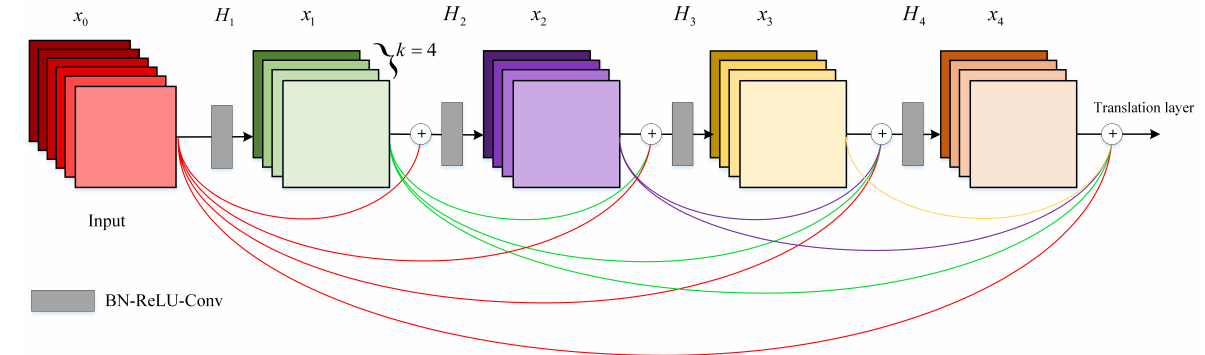
Figure 21. Dense block. 5-layer with a growth rate of k =